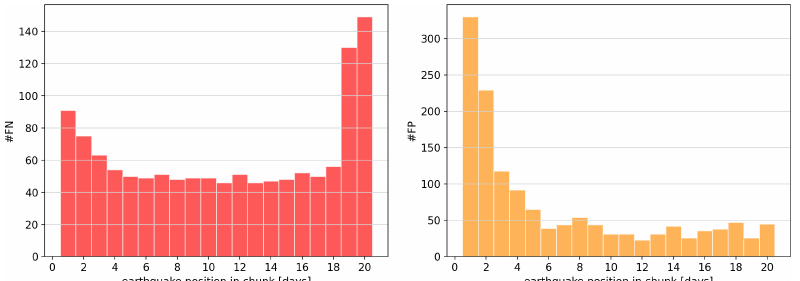
Figure 8. Earthquake position in chunk for wrongly classified samples ( left : FN, right : FP) of the testing data.